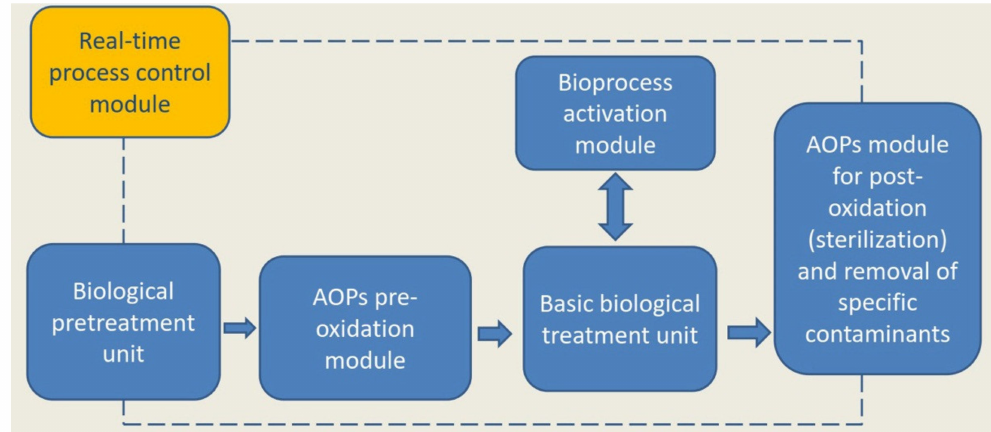
Figure 8. Systemic combination of biological processes and AOPs in wastewater treatment (averaging devices, sand traps, and other pretreatment elements are not